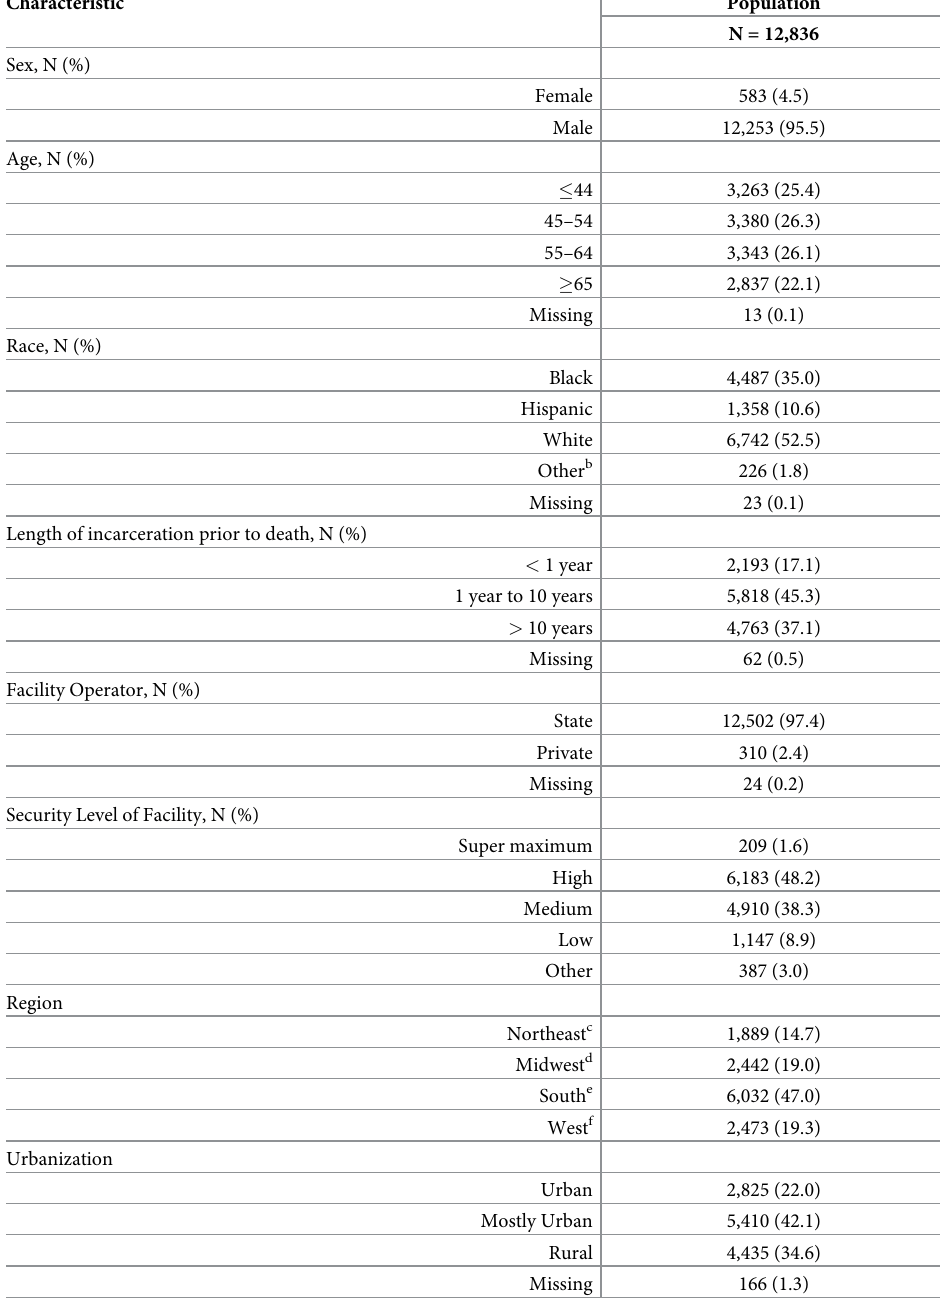
Table 1. Descriptive characteristics of mortality during summer months while under custody of a state or private prison from 2001–2019 a-f